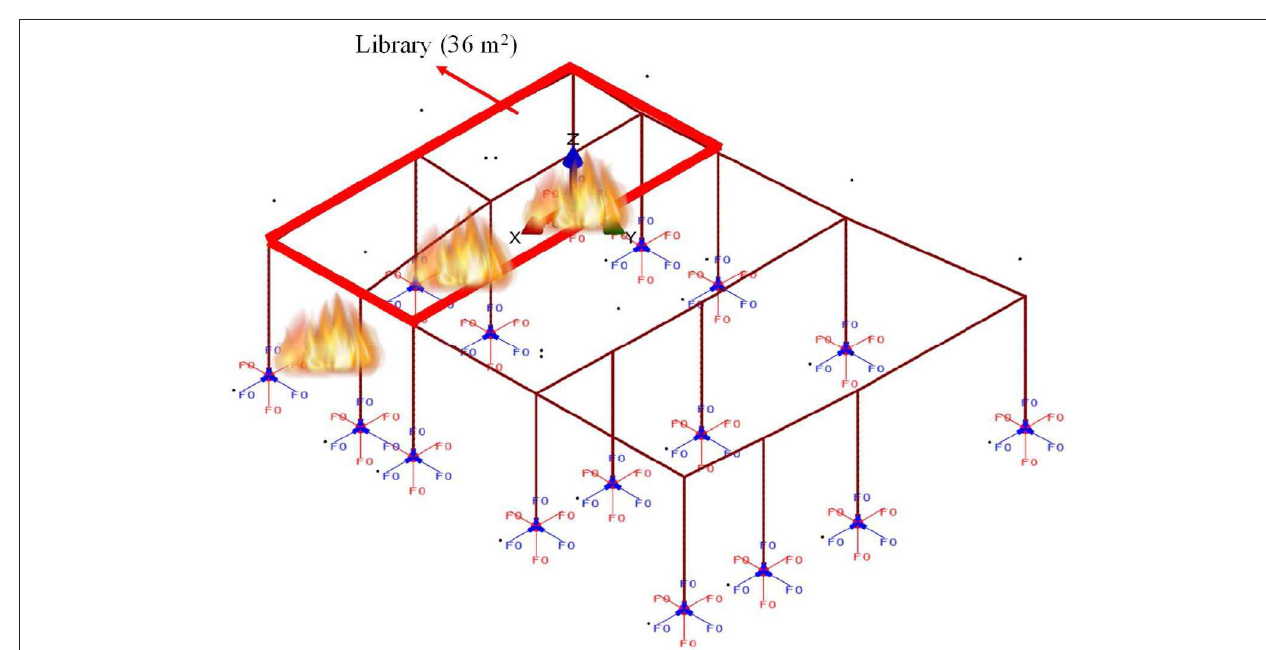
FIGURE 11 | Analyzed